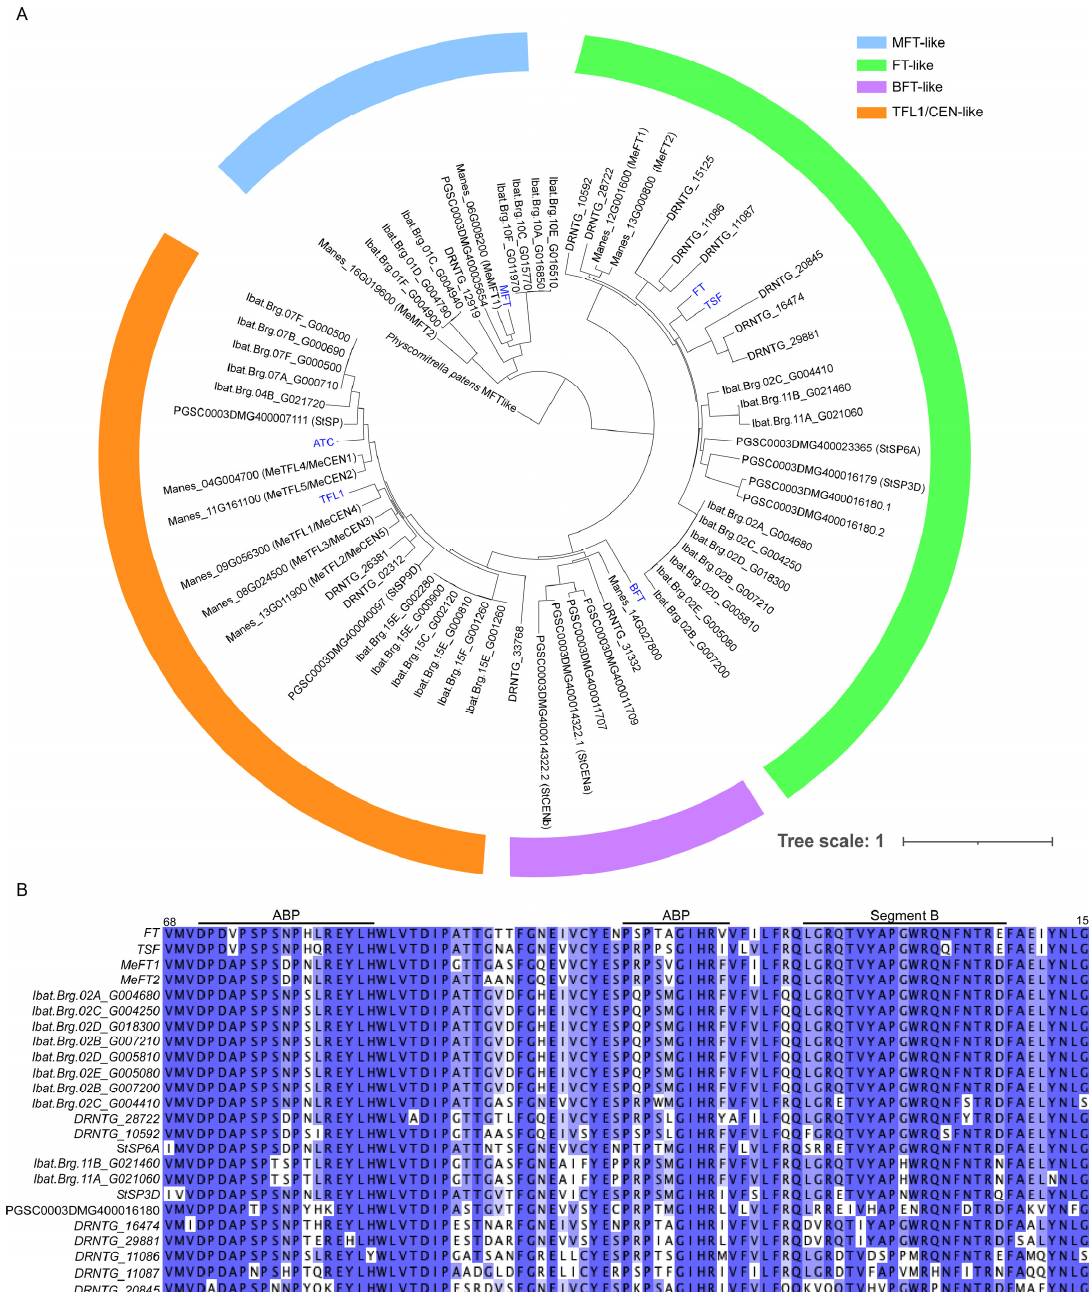
Figure 1. Characterization of PEBP family in tubers and tuberous root crops. ( A ) Phylogenetic tree of the PEBP family in potato, cassava, and yam. The tree was constructed using webtool Phylogeny.fr with the maximum likelihood method [32]. The protein name represents the Ensembl Plants accession number. ( B ) Multiple sequence alignment of the deduced amino-acid sequences of FT for the conserved anion-binding pocket (ABP) and segment B of the fourth exon. Red, green, and blue asterisks represent amino-acid residues that are important for FT movement, FT function, and FT-to-TFL1 neofunctionalization,